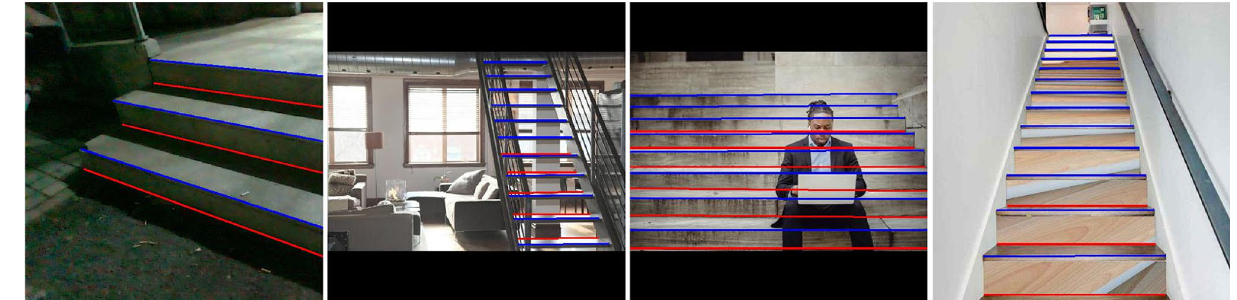
Figure 1. Illustration of the difficulties encountered in stair detection. The convex lines are marked with blue, and the concave lines are marked with red. The figure shows some challenging scenarios, including extreme lighting conditions, special structures, severe occlusions and special